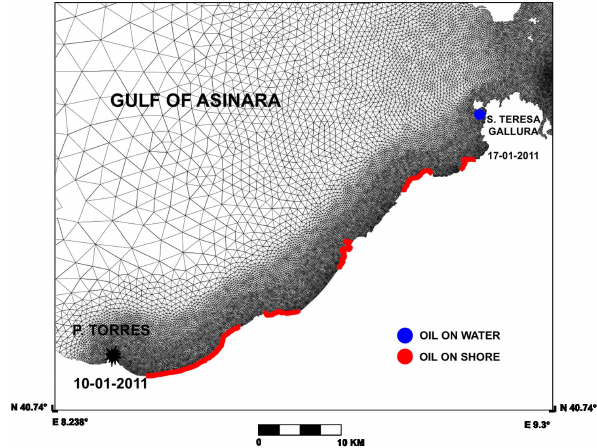
Fig. 6. The extended model domain. In red and blue the sampled beached